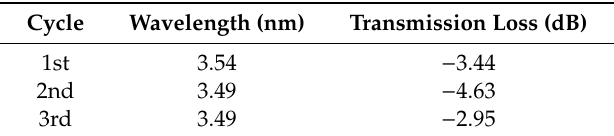
Figure 6. Three-cycle temperature test spectrogram with 10 °C intervals. Table 1. Changes in wavelength shift and transmission loss over three temperature cycles under LPFG (D = 65 µm, Λ = 620 µm).